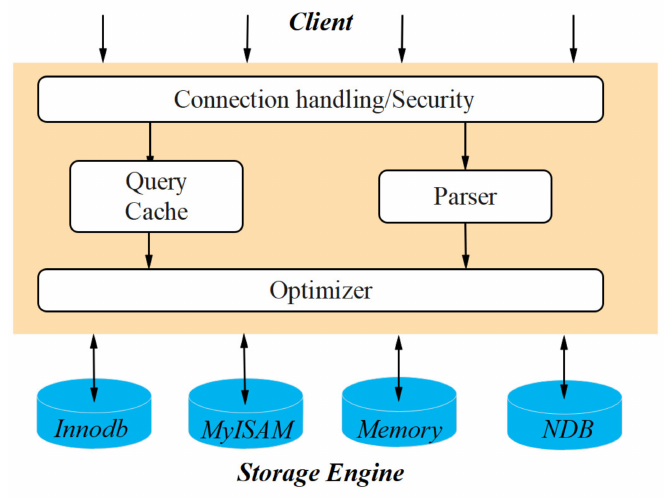
Figure 7. The logical architecture of the MySQL server [18] allows connection and thread handling by both PHP and Python connectors under many operating systems (main layer accessed by client), including Debyan and Raspbian OS; the bottom layer represents responsible functions for MySQL database querying.